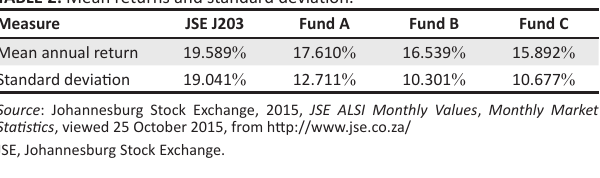
TABLE 3: Correlation. Correlation